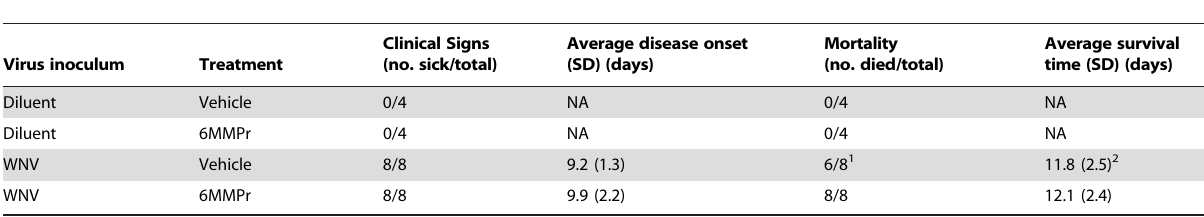
Clinical Signs (no.